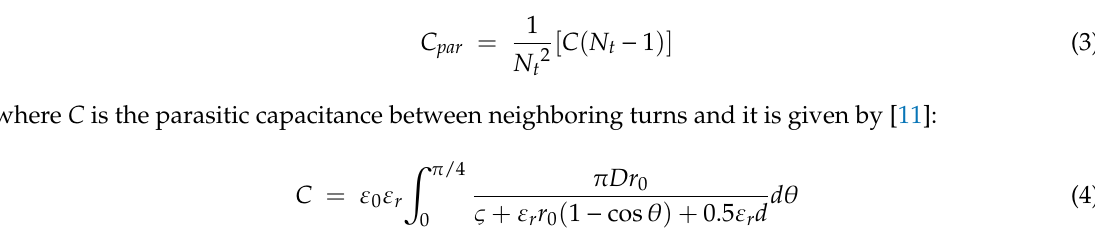
Figure 4. Q -factors’ curves versus operating frequency.